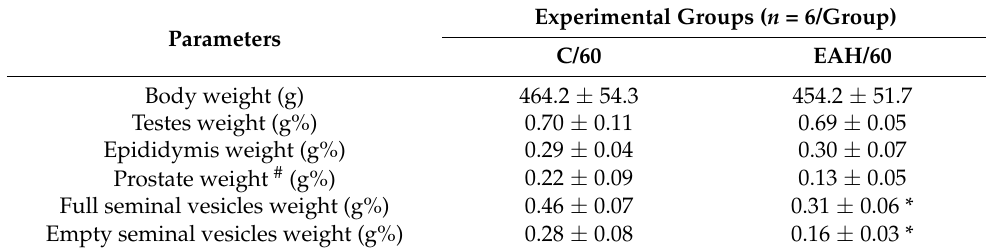
Table 3. Body and organ weights in the experimental groups.